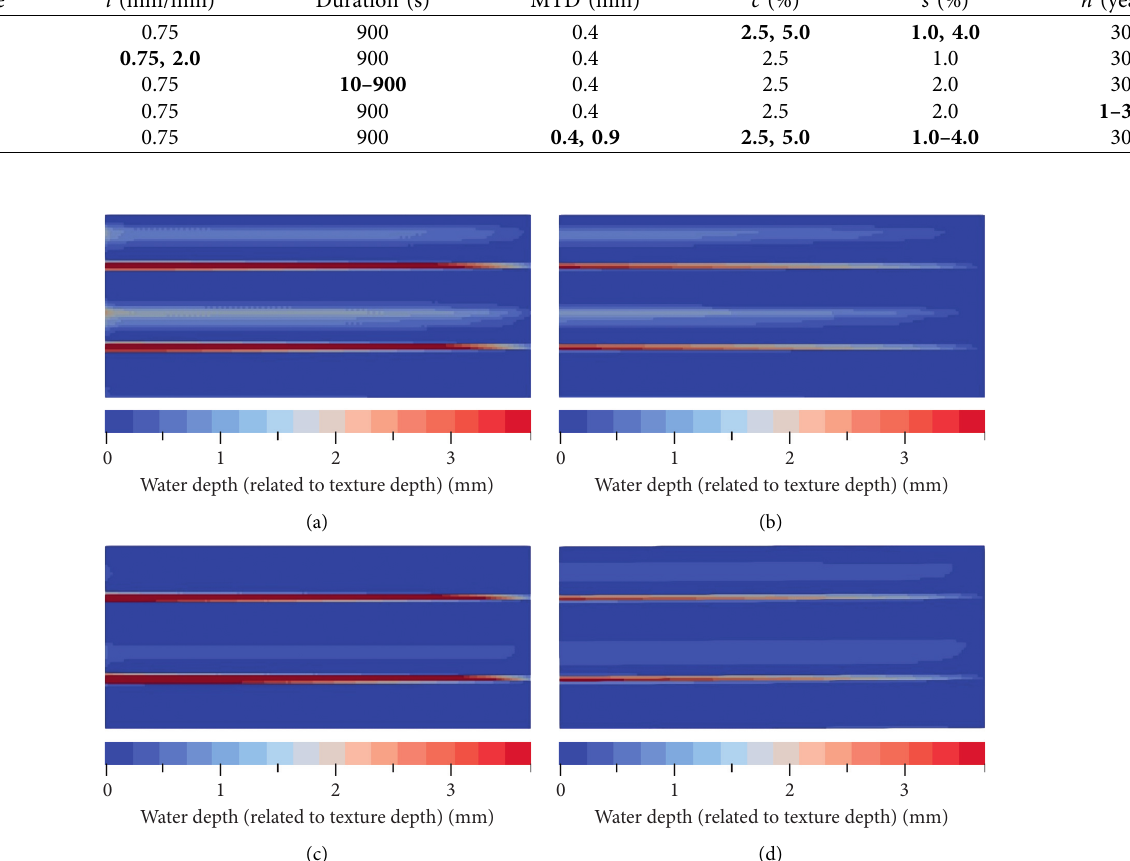
Figure 8: Example 1: effects of cross slope c and longitudinal slope s on the drainage of a pavement surface with ruts (rut depth and geometry after 30 years). (a) c � 2.5%, s � 1.0%. (b) c � 2.5%, s � 4.0%. (c) c � 5.0%, s � 1.0%. (d) c � 5.0%, s �